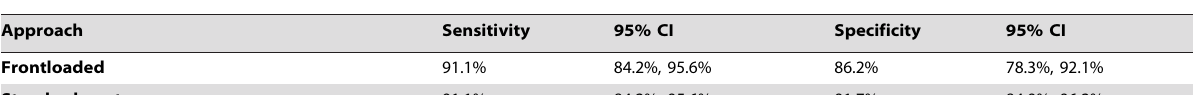
Table 4a. Sensitivity and specificity of frontloading versus standard sputum smears for diagnosis of TB in 221 patients, Mulago hospital, 2011; Table 4b. Negative and positive predictive values of frontloading versus standard sputum smears for diagnosis of TB in 204 patients, Mulago Hospital, 2011.